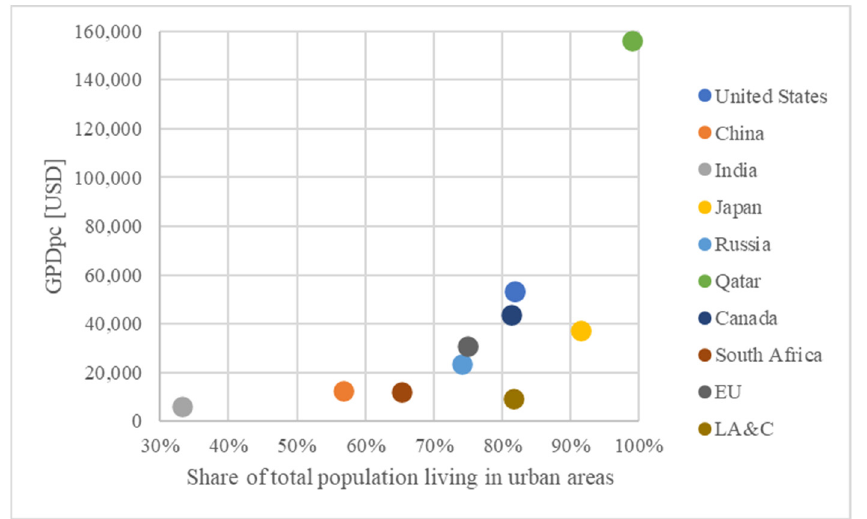
Figure 2. GDPpc is a function of the share of the total population living in urban areas, measured in 2011.